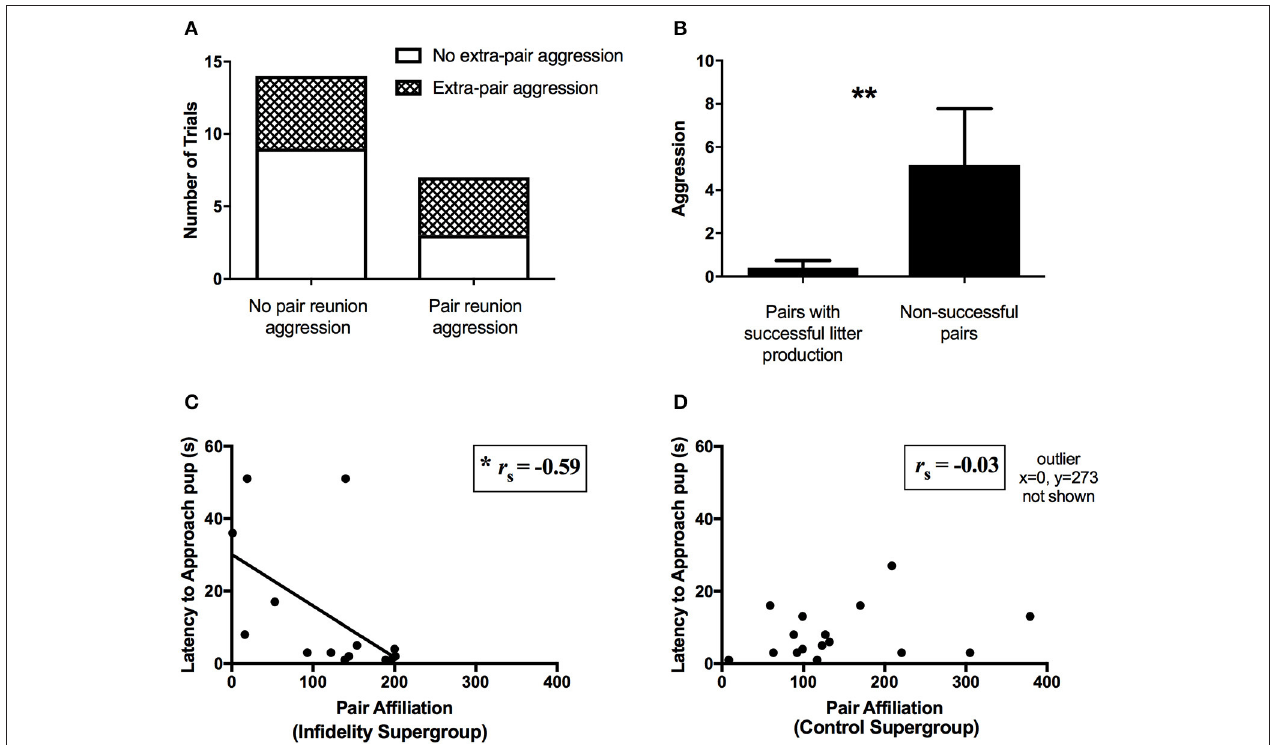
FIGURE 5 | Predictors of pair reproductive success. (A) No association between presence of aggression during the extra-pair interaction at day 14 and presence of aggression at pair reunion on day 21 (Chi square test of independence, N = 21, P = 0.35). (B) Pairs that successfully produced a litter (i.e., had pups and the pups survived to testing day on post-natal day 4, N = 31) showed less aggression at pair reunion than pairs who did not successfully produce a litter ( N = 12) (Mann Whitney test, ** P < 0.01). (C) Among the infidelity supergroup, pair affiliation at pair reunion was negatively correlated with latency to contact pup (i.e., high affiliation corresponded to fast paternal contact of pup) (Spearman’s rank correlation, N = 14, P = 0.025, * P < 0.05). (D) Conversely, among the control supergroup, pair affiliation was not correlated with latency to contact pup (Spearman’s rank correlation, N = 17, P =